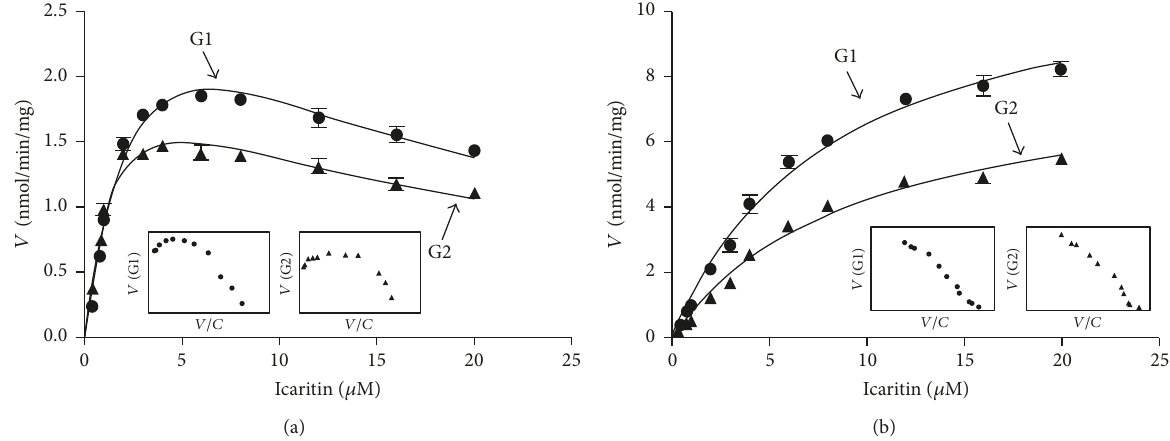
Figure 3: Kinetic profiles for glucuronidation of icaritin by various types of microsomes. (a) Pooled rat liver microsomes (RLM); (b) pooled rat intestine microsomes (RIM). In each panel, the insert figure showed the corresponding Eadie-Hofstee plot.